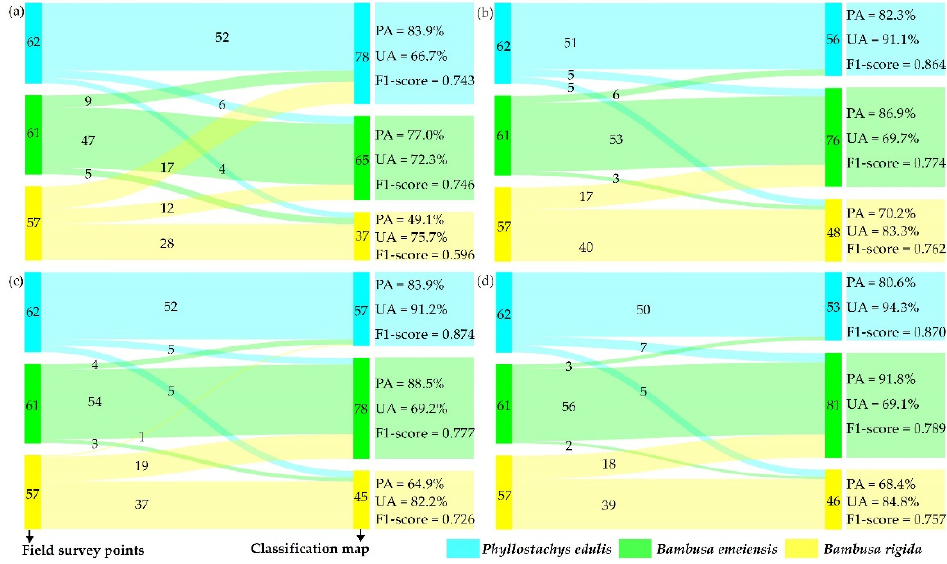
Figure 9. Confusion matrices and evaluation indicators: ( a ) SAM, ( b ) XGBoost (all variables), ( c ) XGBoost (important variables), and ( d ) XGBoost (important and uncorrelated variables).